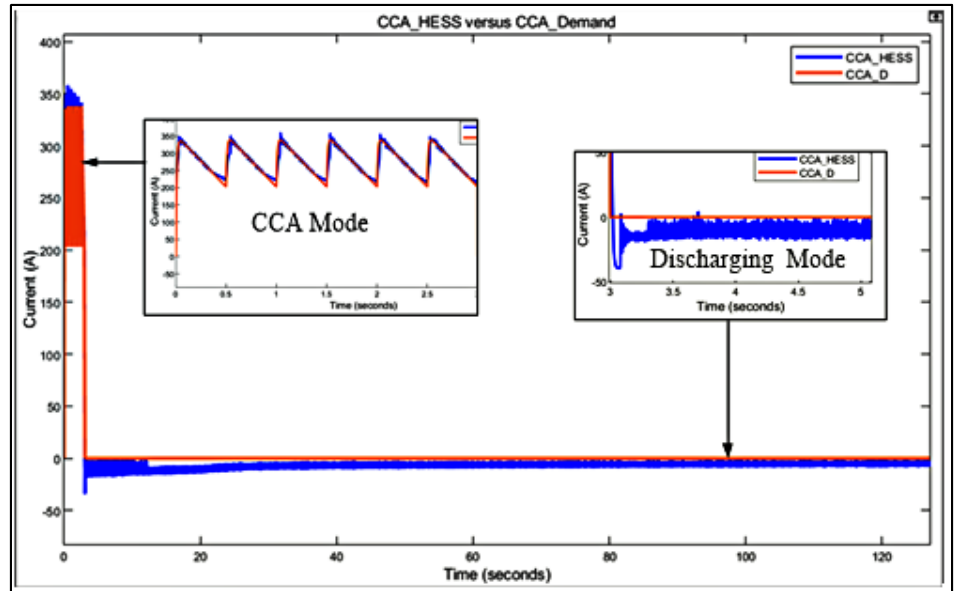
Figure 15. Simulation results of the proposed HESS for case two.